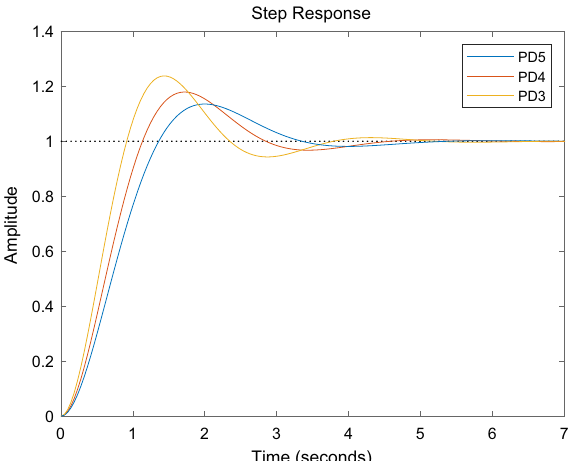
Figure 8. Effect of mass parameter on PD